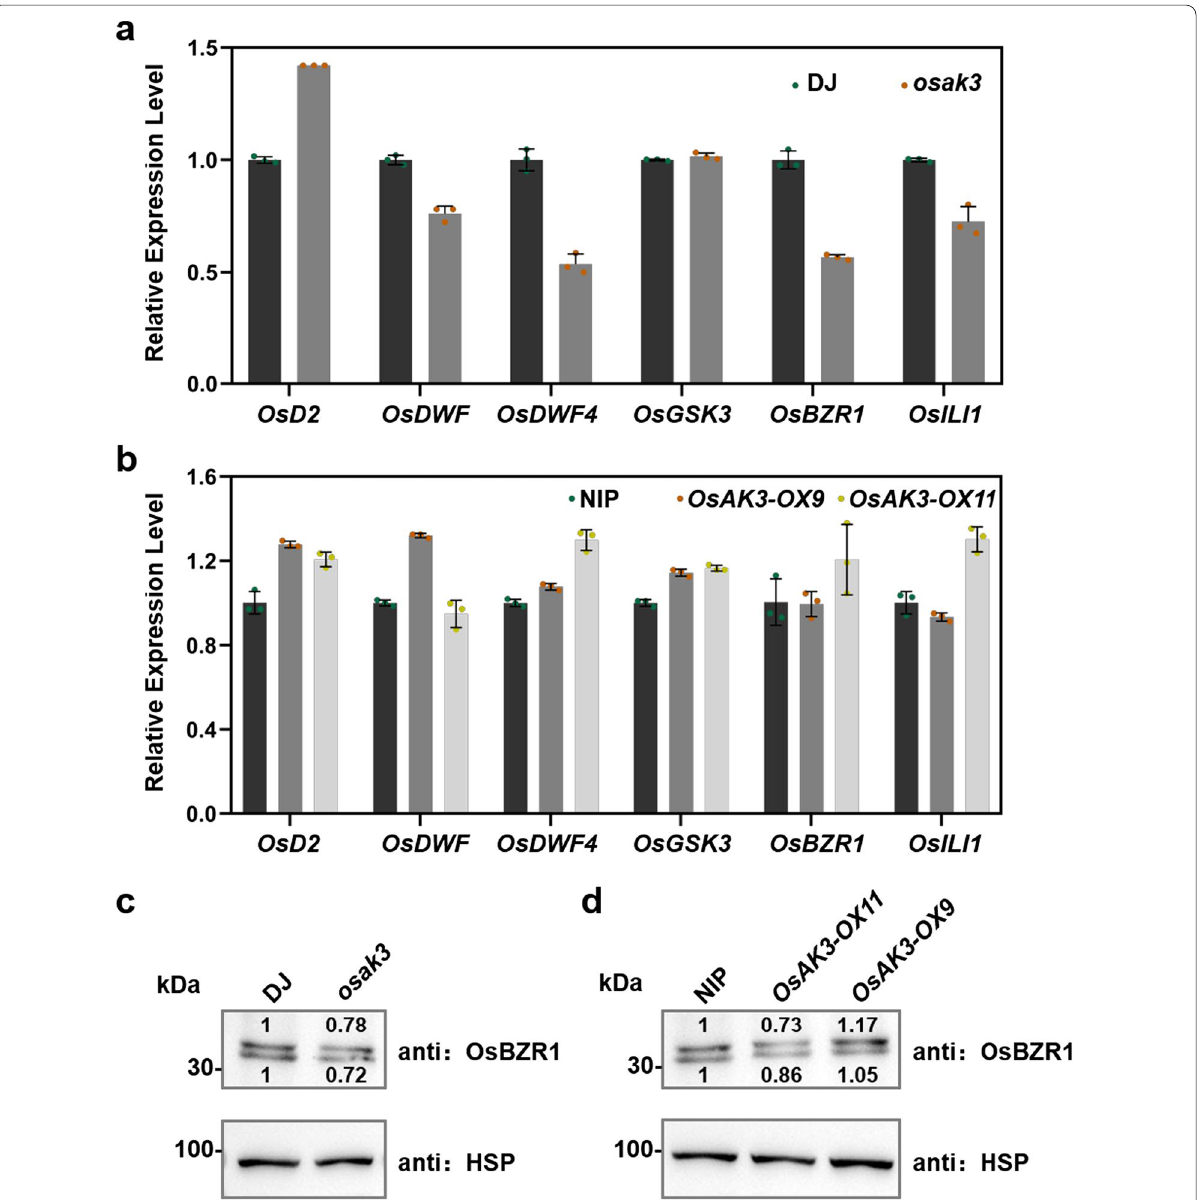
Fig. 6 Expression patterns of BR biosynthesis and signaling-related genes were altered in osak3 . a RT-qPCR analysis of OsD2, OsDWF, OsDWF4, OsGSK3, OsBZR1 and OsILI1 expression in DJ and osak3 . Data are means and OsILI1 expression in NIP and OsAK3-OXs plants. Data are means Western-blot analyses of OsBZR1 protein level in NIP and OsAK3-OXs